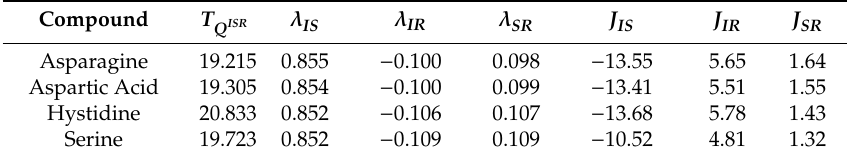
Table 2. Predicted lifetime of Q ISR states for the chosen amino acids with λ coe ffi cients of each spin product operator and the coupling constants between each pair of spins in a field of B 0 = 1 T.